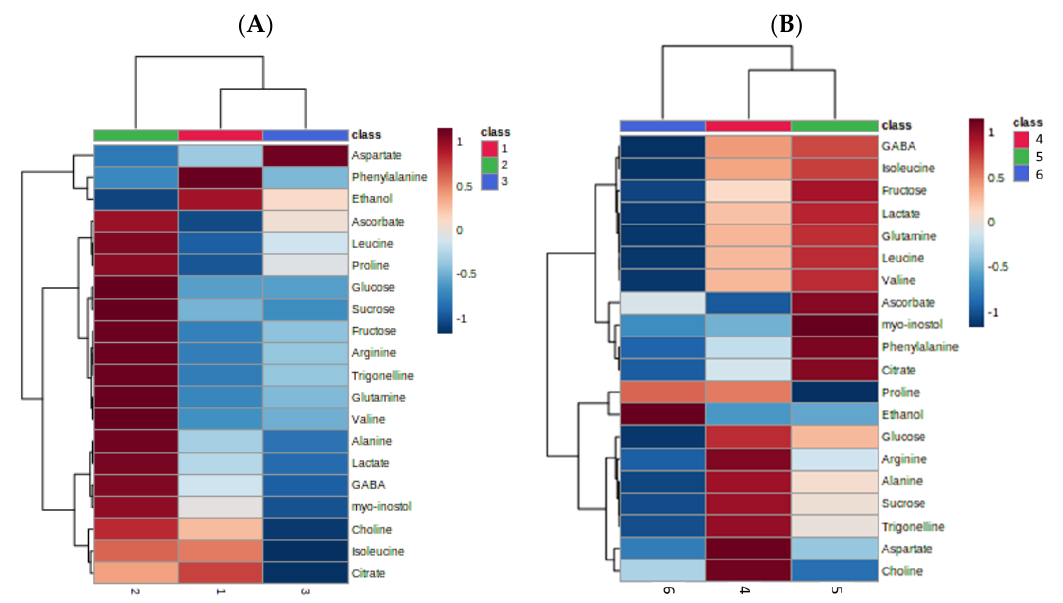
Figure 10. Hierarchical clustering heatmaps of the metabolomic study of lemon juice grown in 9 different treatments (3 rootstocks × 3 substrates). The results are analyzed according to ( A ) the rootstock used ( n = 3) and ( B ) the substrate ( n = 3), where 1 to 3 corresponds to the rootstock type as (1) Citrus macrophylla ; (2) Citrus aurantium ; and (3) Citrus aurantium/Citrus sinensis ; and 4 to 6 is related to the culture media: (4) 75% peat + 25% port sediment; (5) 50% peat + 50% port sediment; and (6) 25% peat + 75% port sediment.